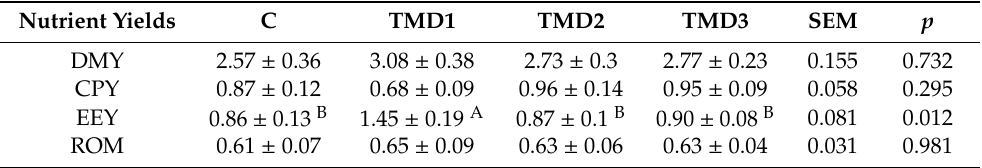
Table 6. Yield (g / larvarium) of dry matter, crude protein, ether extract, and residual organic matter for BSFPs reared on the control (C) or experimental diets (TMD1–TMD3). Nutrient Yields C